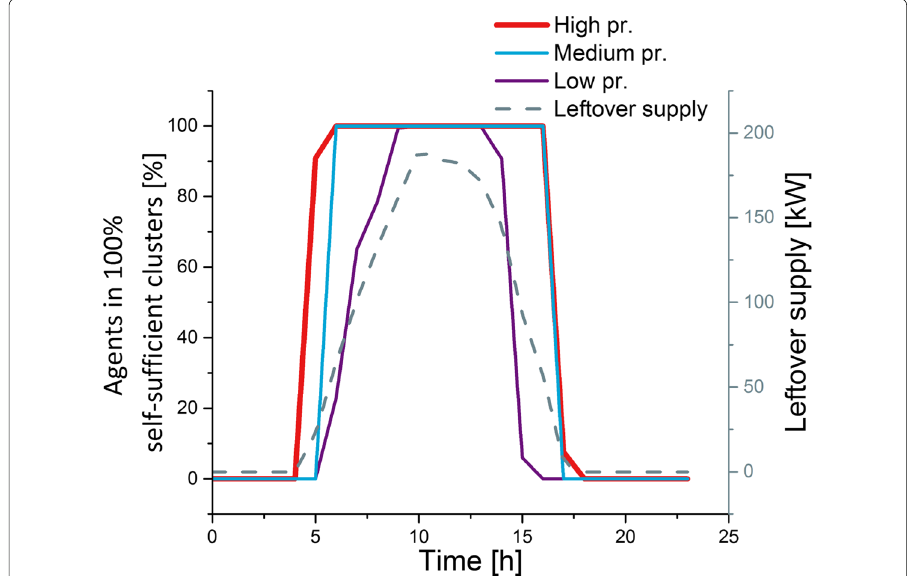
Fig. 8 Percentage of non-self-sufficient agents of each priority that are in 100% self-sufficient